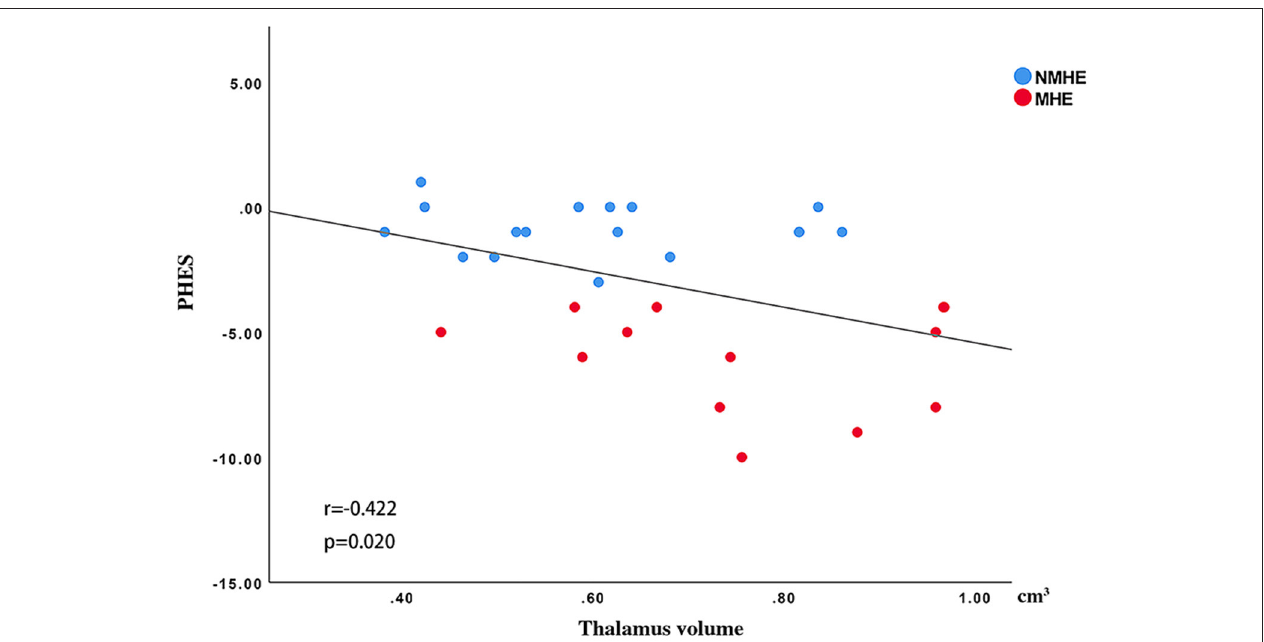
FIGURE 5 | Spearman’s correlations between the thalamus volume and PHES. The thalamus volume was negatively correlated with PHES performance in all cirrhosis patients. NMHE, patients without MHE; MHE, minimal hepatic encephalopathy; PHES, psychometric hepatic encephalopathy